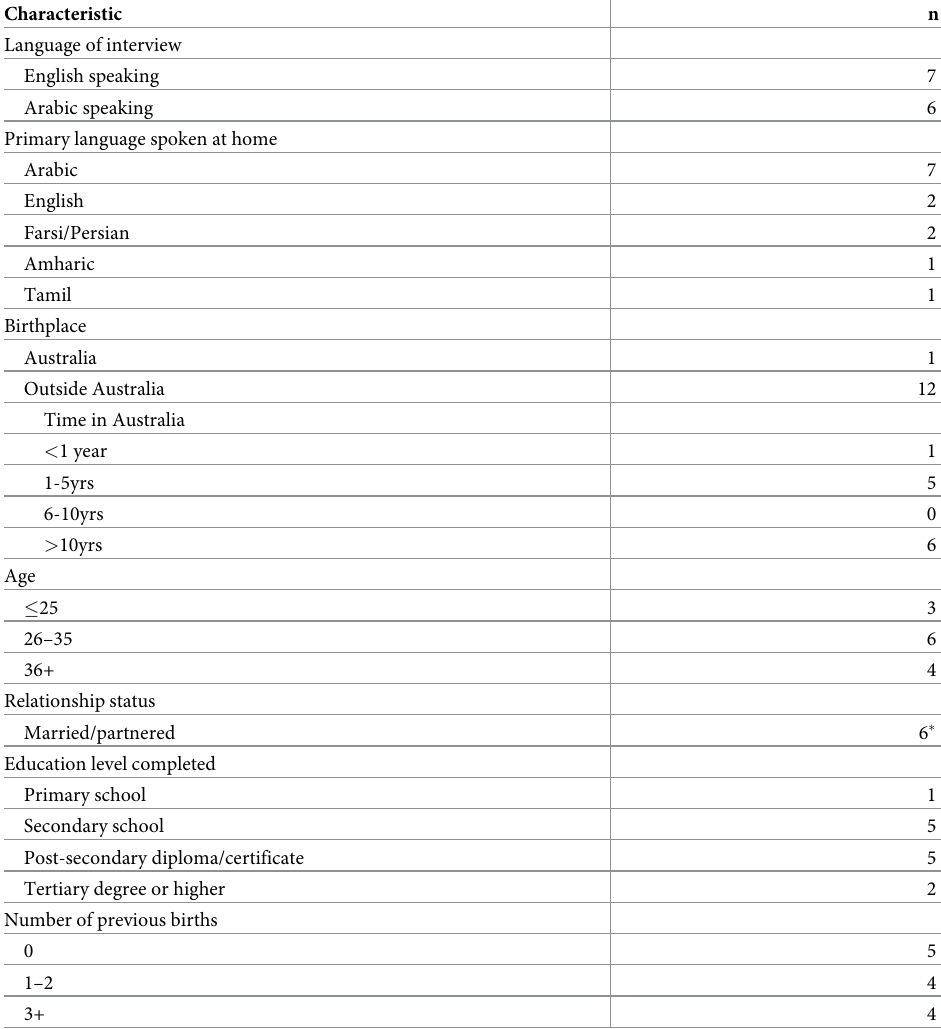
Table 1. Characteristics of women (clients)